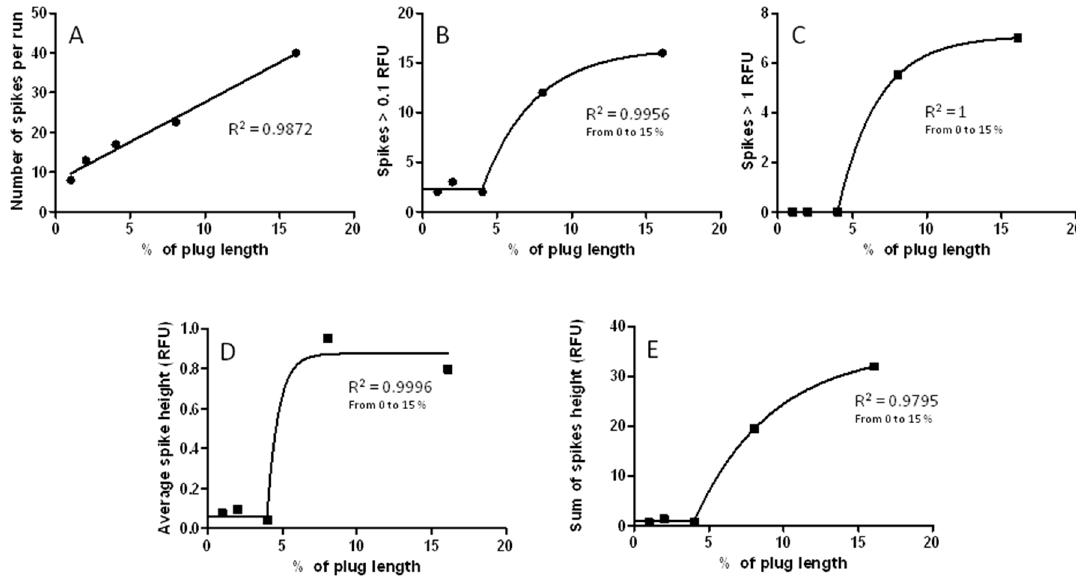
Figure 5. Effect of injection volume (expressed as percentage of sample plug length to effective capillary length) on: ( A ): the number of spikes; ( B ): the number of spikes higher than 0.1 RFU; ( C ): the number of spikes higher than 1 RFU; ( D ): the average height of spikes and ( E ): the sum of spikes height, when analyzing 13-day incubated A β 1-40. Running buffer as in Figure 1. Curve fitting: ( A ): linear regression; ( B – E ): non-linear fitting, plateau followed by one phase association.